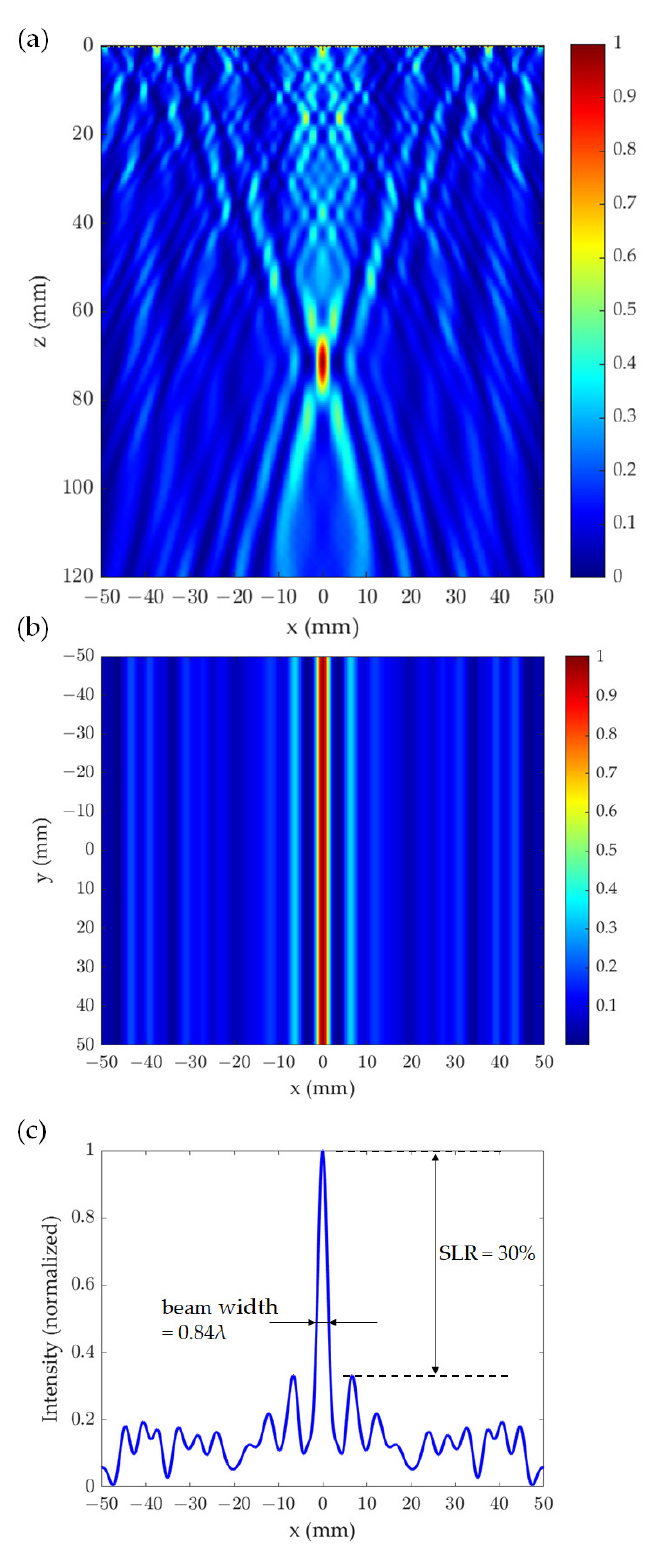
Figure 4. Characteristics of the transmitted THz beam by the cylindrical super oscillatory lens (CSOL), which was optimized for 0.1 THz and desgined with a focal length of 70 mm. ( a ) Normalized intensity pattern on the xz plane at y = 0 mm; ( b ) normalized intensity pattern at z = 70 mm on the xy plane, which is the focal plane; and ( c ) the intensity profile along the x direction at y = 0 mm and z = 70 mm.